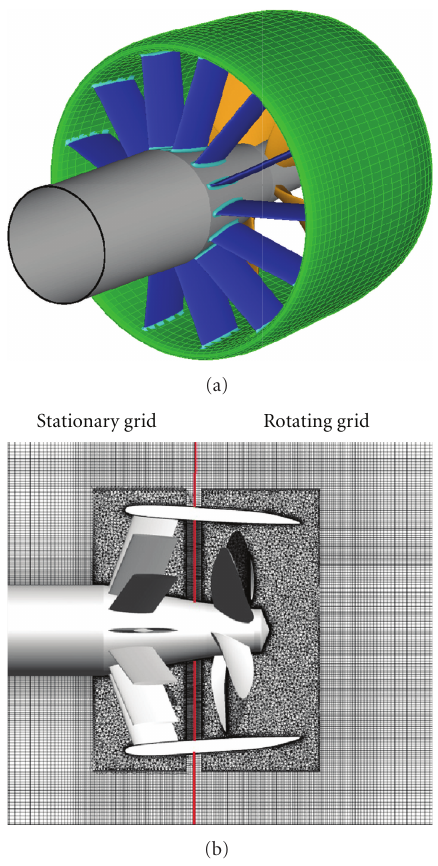
Figure 15: (a) Geometry of ducted propulsor with stator blades, (b) computational grid for ducted propulsor with stator blades.